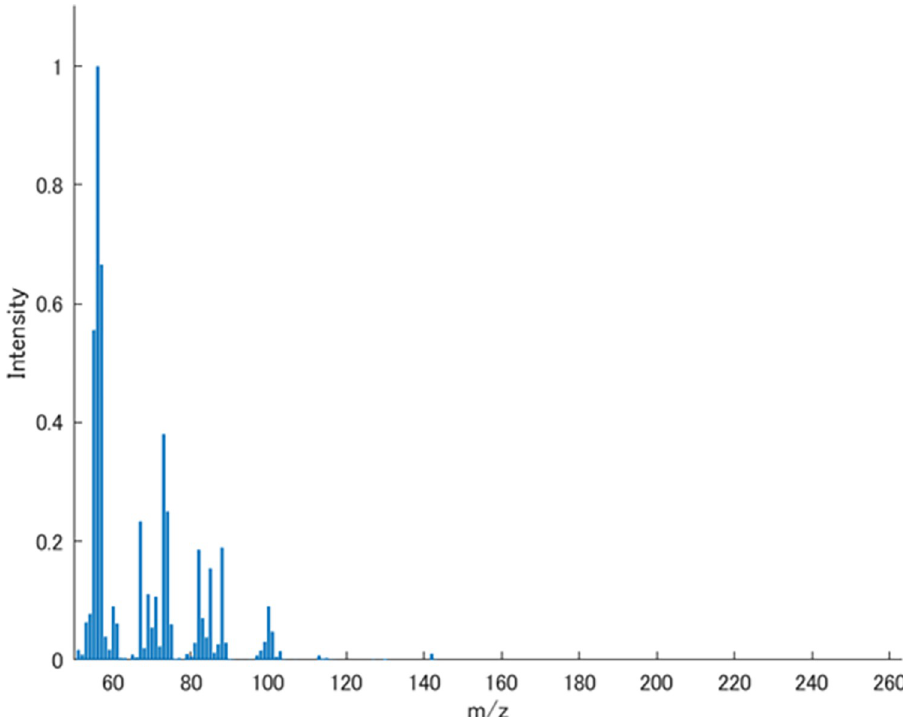
Fig 5. Mass spectrum of the virtual apple flavor.